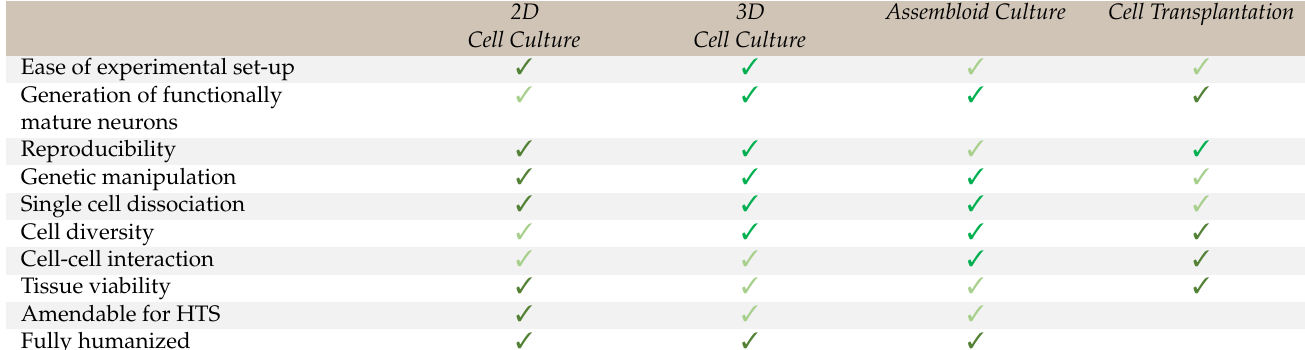
Table 1. Comparison of human stem cell models. 2D Cell Culture